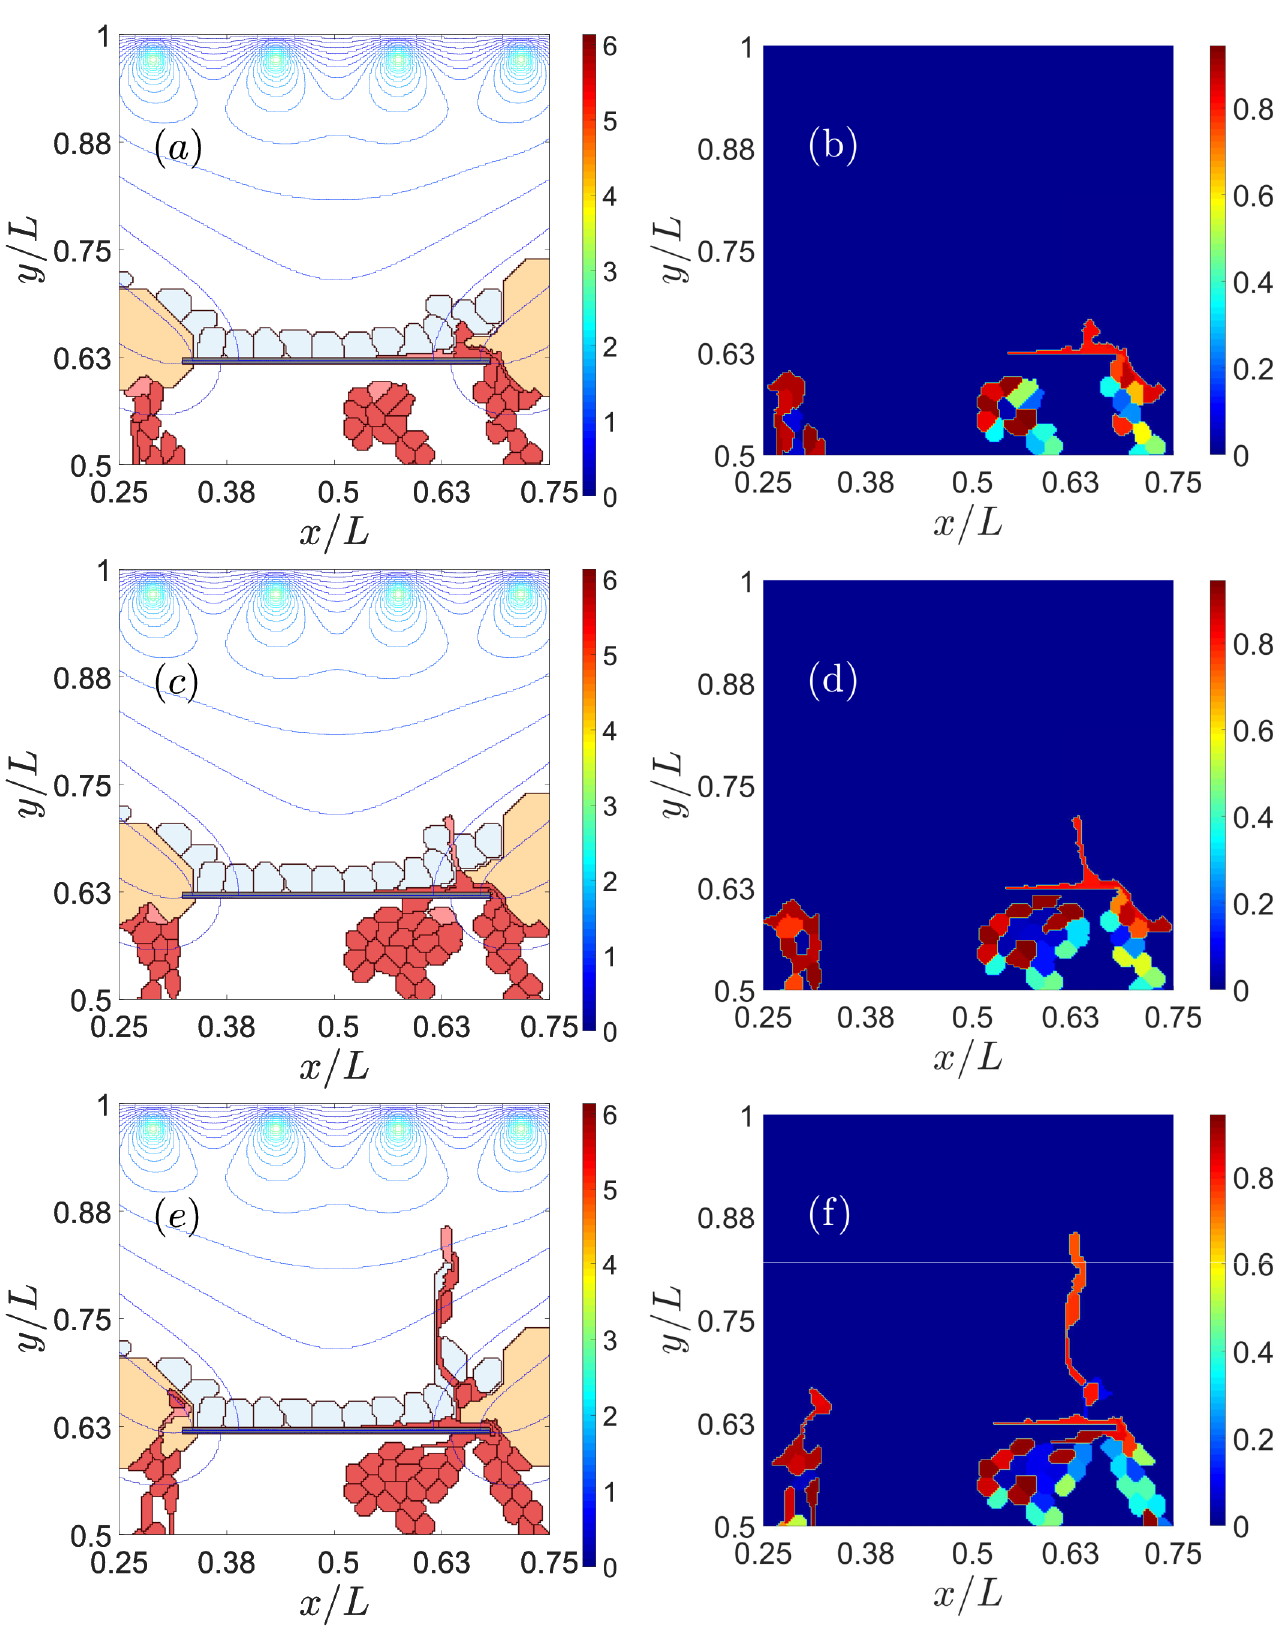
Figure 6. Type 2 CNV favored by the point where the sprout cross the RPE (left column: ( a ), ( c ), ( e )). Amount of VEGF receptors of ECs (right column: ( b ), ( d ), ( f )). Snapshots at times: ( a ), ( b ) 1201 MCTS, ( c ), ( d ) 1501 MCTS, ( e ), ( f ) 3001 MCTS.